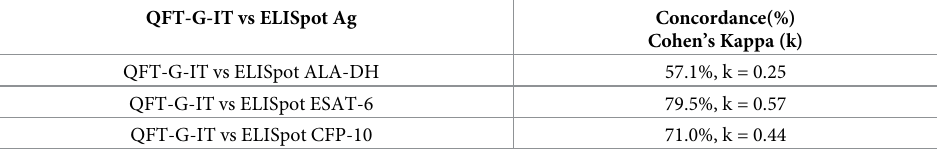
Table 4. Concordance between QFT-G-IT and IL-2 based ELISpot for each antigen in the study, for all the 210 enrolled